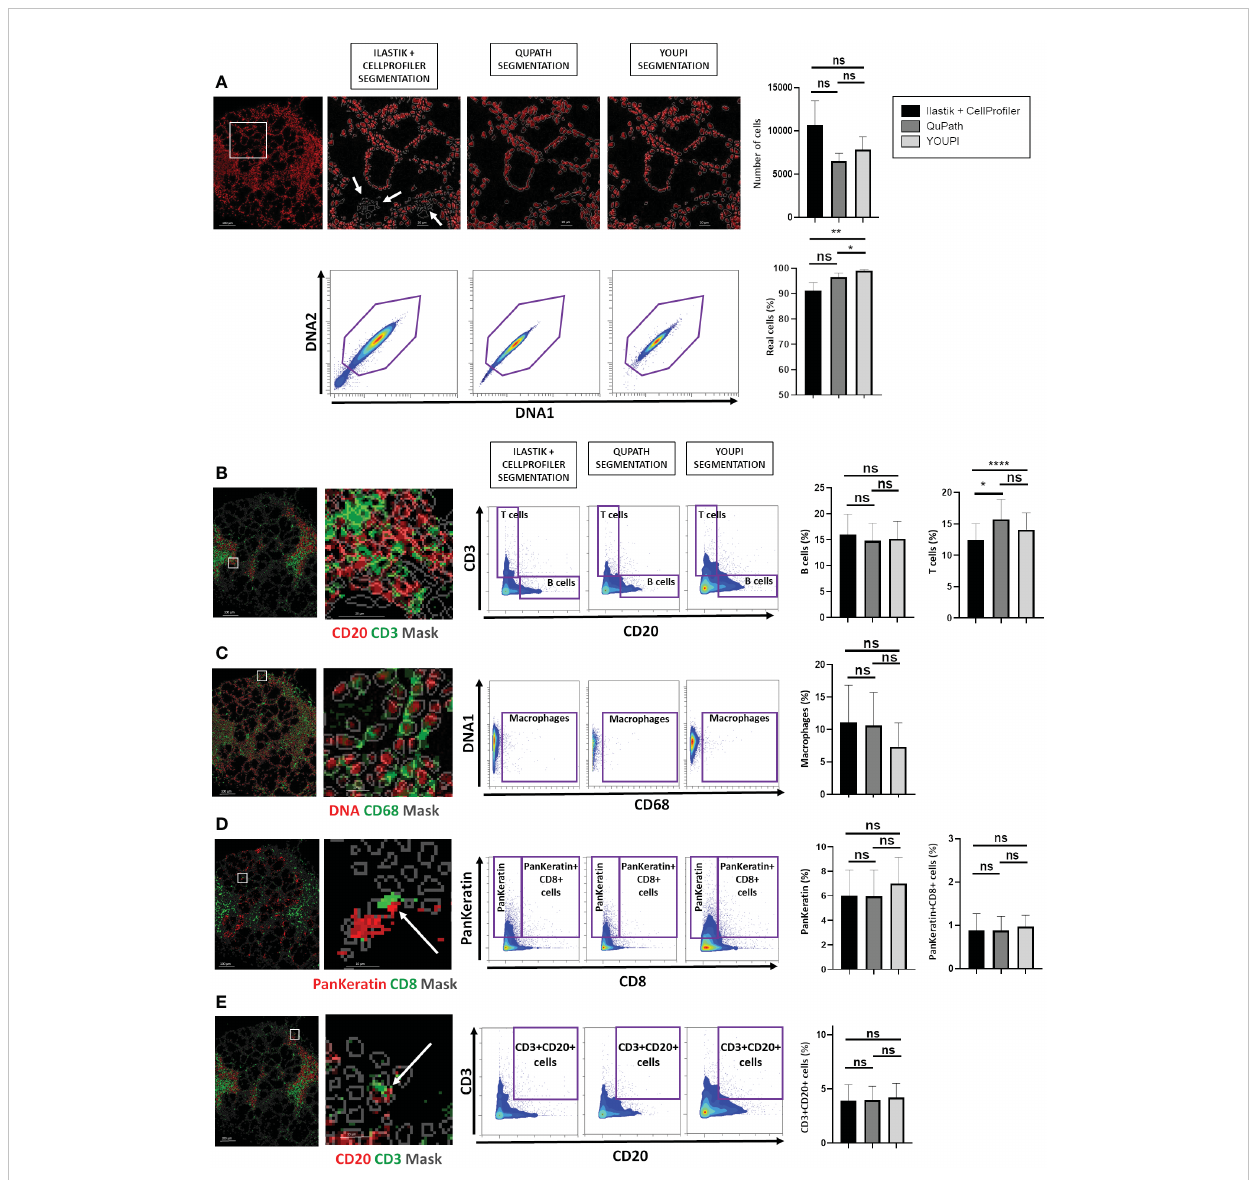
FIGURE 7 Biological metrics for evaluating cell segmentation performance. Eighteen ROI were segmented with Ilastik and CellPro fi ler, QuPath and YOUPI software. (A) Example of false cells (white arrows) found without DNA detection of the nuclei shown in red and the segmented mask of cells in gray. Two nuclei signals were used to establish the presence of existent cells. The number of cells and the percentage of real cells in the 18 ROI were determined. (B) Example of CD20 (red) and CD3 (green) detection with the YOUPI-generated mask shown in gray. The percentages of CD20+ B cells and of CD3+ T cells among the 18 ROIs were calculated. (C) Example of DNA1 (red) and CD68 (green) detection with the YOUPI-generated mask shown in gray. The percentage of CD68+ macrophages among the 18 ROIs was calculated. (D) Example of PanKeratin (red) and CD8 (green) detection, with the YOUPI-generated mask in gray. The white arrow indicates the detection of double-positive cells (white square). The percentages of PanKeratin+ cells and of double PanKeratin+ and CD8+ cells among the 18 ROIs were calculated. (E) Example of CD20 (red) and CD3 (green) detection with the YOUPI-generated mask shown in gray. The white arrow indicates the detection of double-positive cells (white square). The percentage of double CD3+ and CD20+ cells among the 18 ROIs was calculated. *p< 0.05, **p< 0.01, ****p< 0.001, ns, non-signi fi